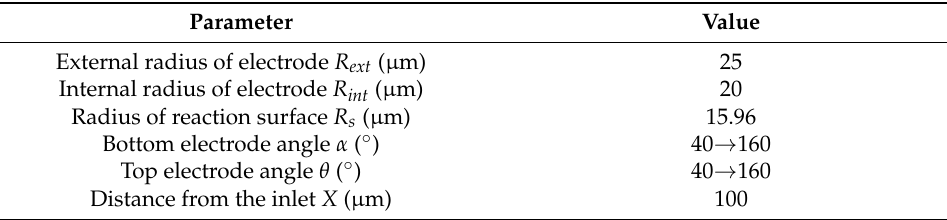
Table 1. Geometrical parameters for type 1 of the biosensor model.